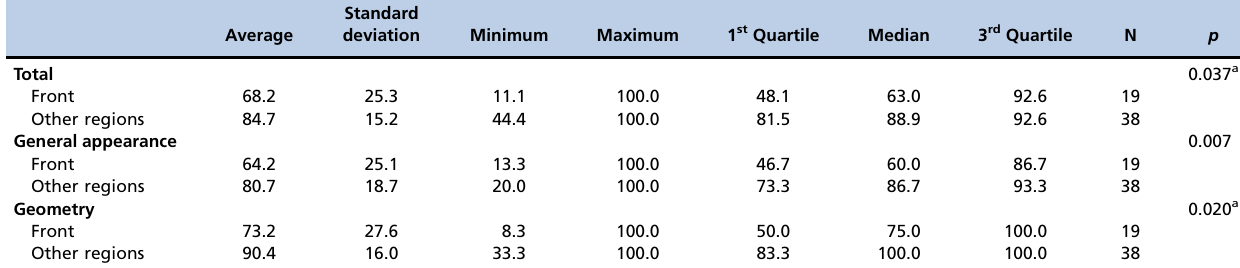
Table 3 - Summary measures of facial satisfaction factors by procedure location - frontal region. Average